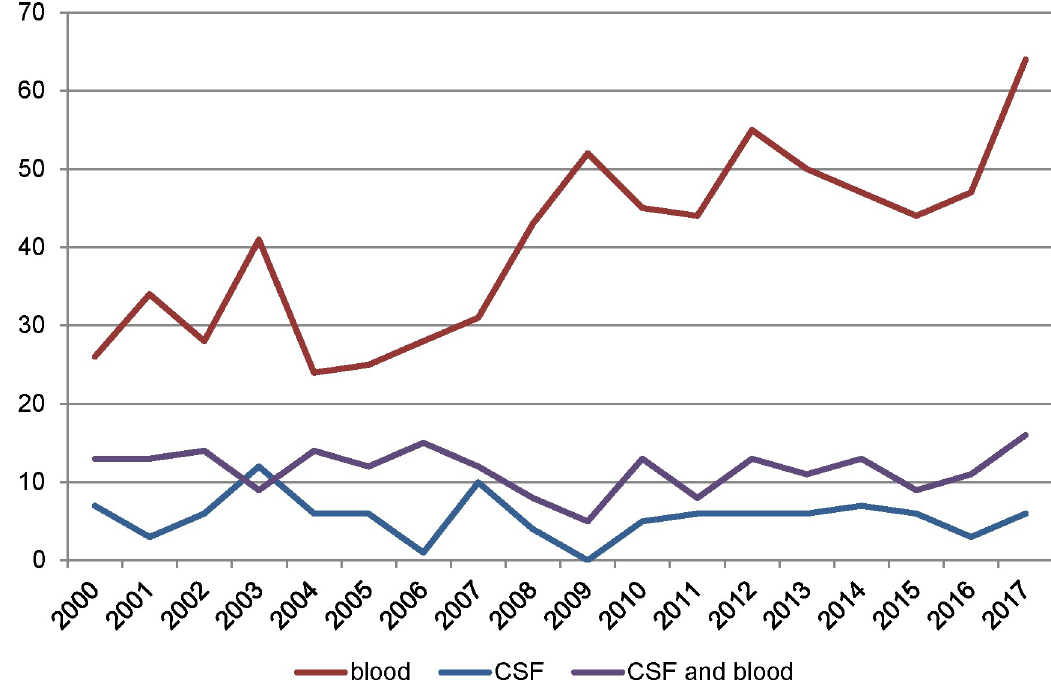
Fig 2. Number of GBS isolates from neonates (age 0–90 days) received by the NRLBM, by culture specimen type. CSF: cerebrospinal fluid; GBS: group B Streptococcus; NRLBM: Netherlands Reference laboratory for Bacterial